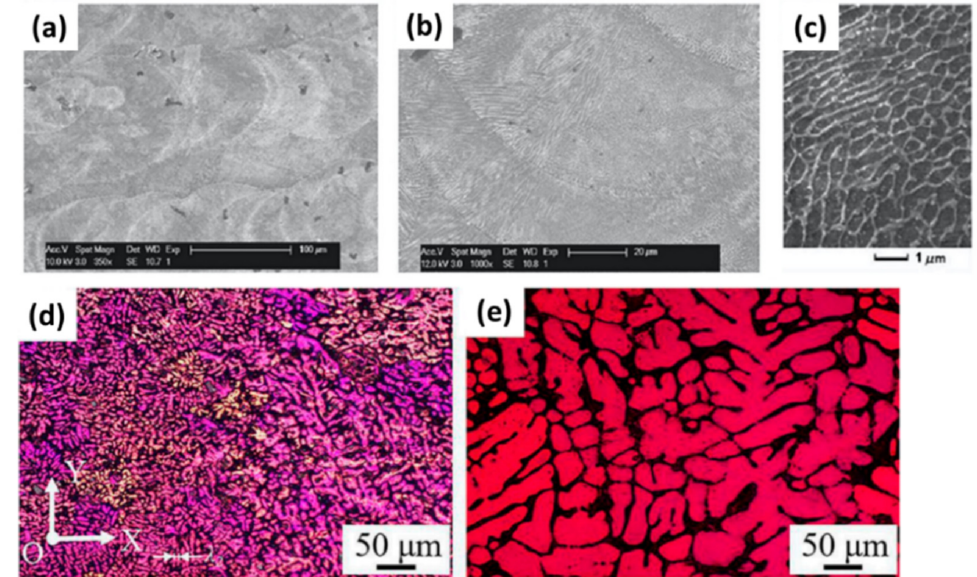
Figure 4. SEM images of LBM-printed ( a – c ) 18 Ni-300 steel showing finer grains [53]. ( d , e ) The grain size of the as-deposited and as-cast ALSiMg0.6